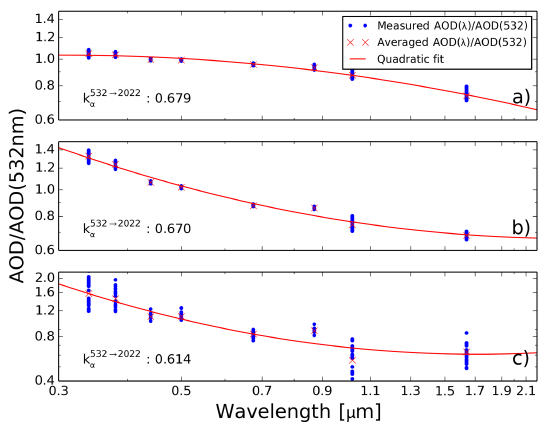
Figure 11. Estimated extinction coefficient conversion factor k 532 → 2022 α based on sun photometer AOD measurements for three different aerosol types. (a) Dust: the wavelength dependency was calculated based on 103 AOD measurements (blue dots) on 26 June (between 12:07 and 21:05UTC), 10 July (between 10:33 and 21:20UTC) and 11 July (between 13:16 and 20:09UTC). (b) Mixed aerosol: for this case, 33 AOD measurements taken on the 6 July, be- tween 15:48 and 21:26UTC, were used for the estimation. (c) Ma- rine aerosol: 31 AOD measurements from 7 July, between 12:30 and 19:58UTC, were